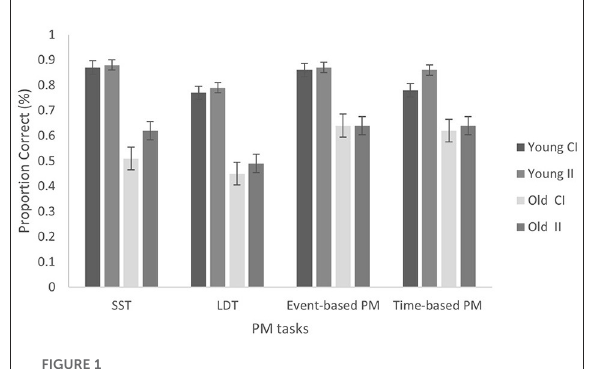
FIGURE1 PM performance in all PM tasks for both age groups and conditions. Error bars represent the standard error (SE). CI, Conventional Instructions; II, Implementation